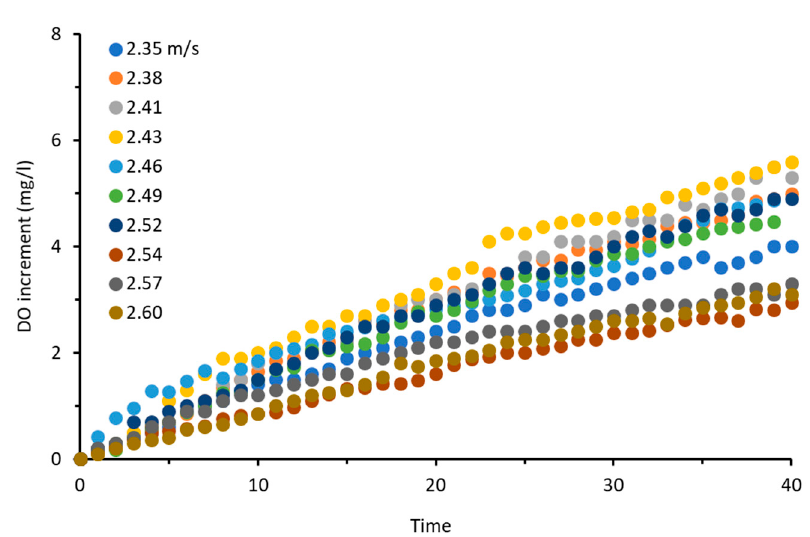
Figure 6. Effect of liquid velocity on dissolved oxygen (DO) increment against time at fixed gas velocity of 3 L/min. The DO increment is presented as relative to the initial DO reading.